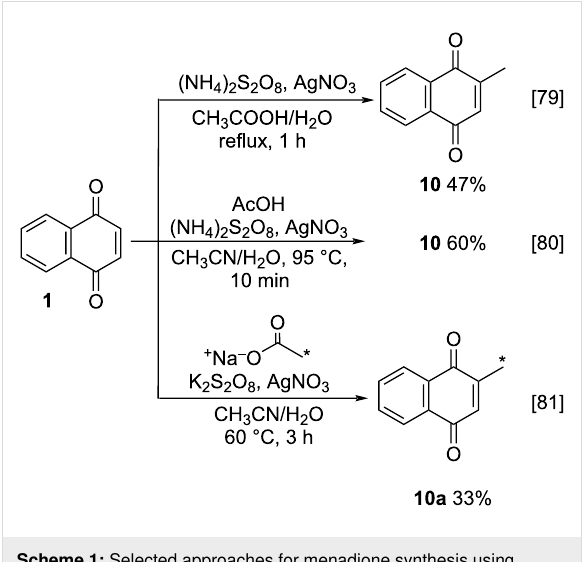
Scheme 1: Selected approaches for menadione synthesis using silver(I) as a